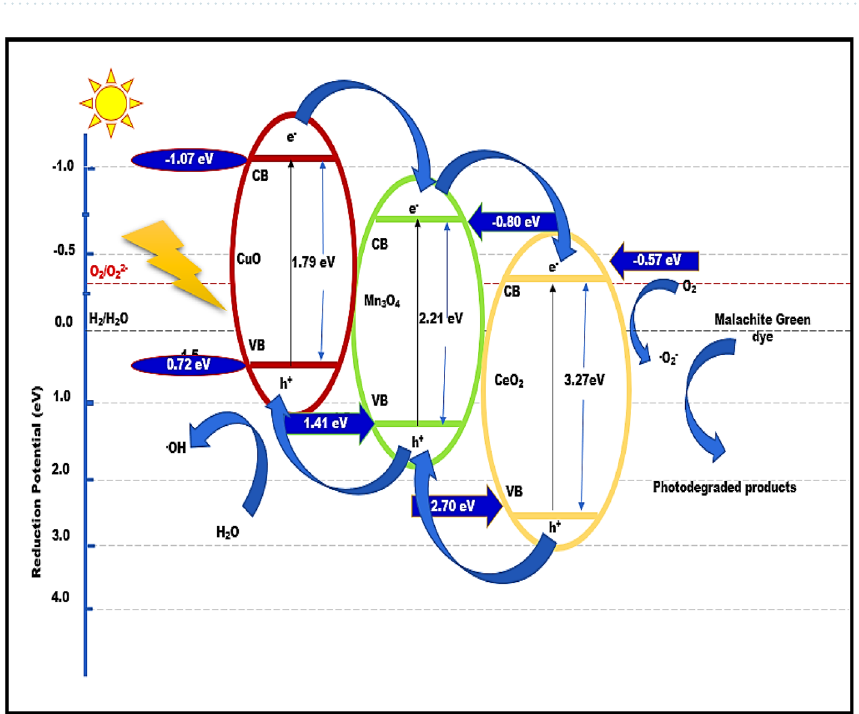
Figure 17. ( a ) Schematic presentation of plausible mechanism for photodegradation of Malachite green dye using designed heterostructure CuO /Mn 3 O 4 / CeO